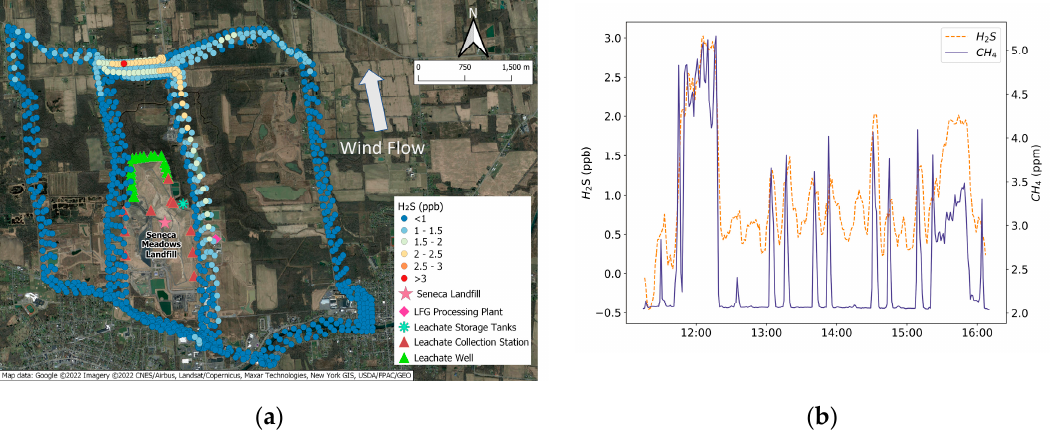
Figure 7. Seneca plots: ( a ) The outer and inner loops driven around Seneca Meadows Landfill, and the H 2 S measurement MRs associated with the south–southeasterly wind vector in the top right, which was sustained throughout the period of measurements. Each loop was slightly offset to the right and below the prior loop to prevent overplotting. ( b ) The 1-minute time-series plot of H 2 S (ppb) and CH 4 (ppm) for the entire period of